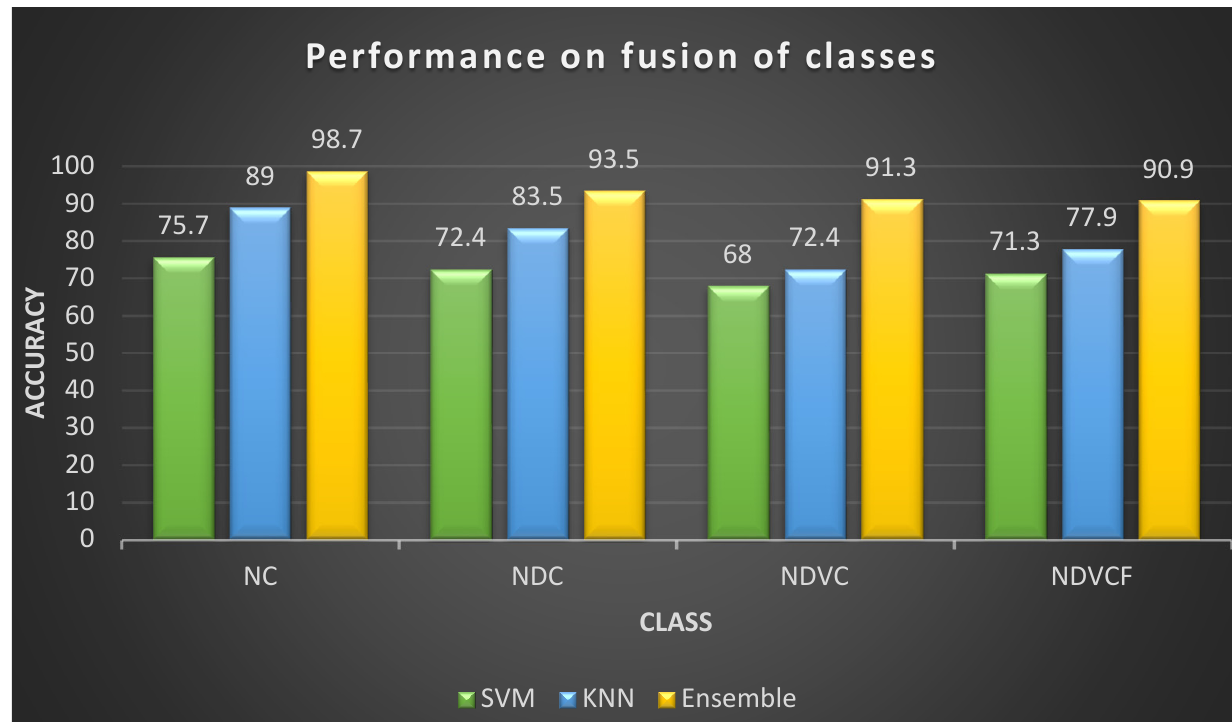
Figure 6 . Comparison on classification of EOG in hypovigilance detection. Figure 6. Comparison on classification of EOG in hypovigilance detection. Based on the EOG performance for hypovigilance detection, the maximum accuracy that was obtained was 90.9% from the ensemble classifier. Other corresponding perfor- mance metrics such as sensitivity, specificity, precision, and error rate were also calculated using the confusion matrix Figure 7. False positives and false negatives are some of the valuable factors which affect the process of making correct decisions in finding specific problems in the human body [49].